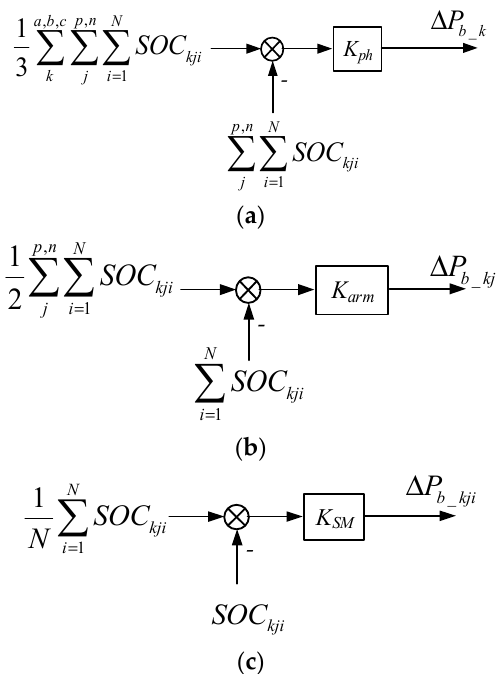
Figure 4. Three-level State-of-charge (SOC) equalization control. ( a ) SOC equalization among three phases. ( b ) SOC equalization between upper and lower arms. ( c ) SOC equalization among submodules (SMs) within phase arm.